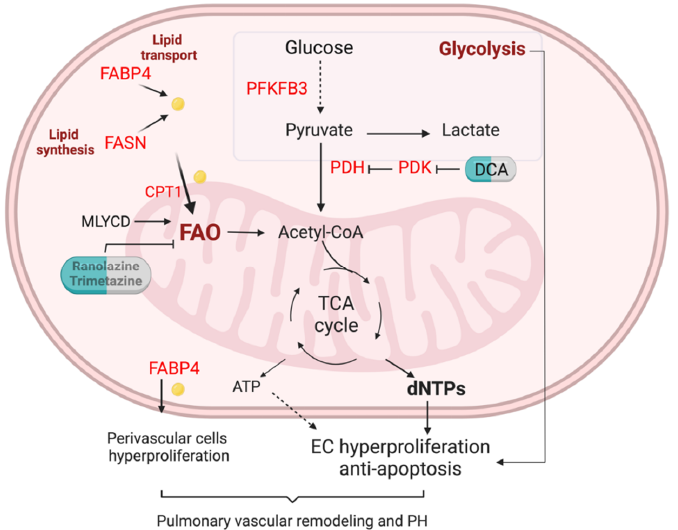
Figure 2. FA metabolism in the lung EC of pulmonary hypertension. Enhanced glycolysis is evident in PAH ECs. Lipid transport via FABP4, lipid synthesis via fatty acid synthase (FASN), and fatty acid oxidation (FAO) are unregulated in pulmonary arterials of PAH patients. Elevation of FA could increase mitochondria FAO, contributing to the generation of dNTPs and ATP. Enhanced FAO and glycolysis lead to PAH EC hyperproliferation and anti-apoptotic phenotypes. Upregulation of FAPB4 could also increase FA efflux to perivascular cells such as pulmonary arterial smooth muscle cells and fibroblasts, and promote pulmonary vascular remodeling and PH. Pulmonary arterial hypertension (PAH), or group 1 PH, is an incurable lung disease, characterized by increased resistance in the pulmonary vascular system, which will finally lead to elevated resting pulmonary artery pressure and end by right ventricular failure [82]. Accumulating evidence has demonstrated that EC dysfunction plays a crucial role in the initiation and progression of PAH, manifested by increased susceptibility to injury and enhanced proliferation, contributing to the formation of plexiform lesions [83–86]. Indeed, most PAH mutation-causing genes are mainly expressed in the lung ECs based on the human lung single-cell RNA sequencing analysis [87]. To date, increasing evidence indicates that EC metabolism dysfunction is closely associated with the pathogenesis of PAH [88–90]. The major observed metabolic alteration of EC metabolic change in PAH has increased glycolysis [88]. Glucose metabolic activities were higher in the lungs of PAH patients than in healthy individuals determined by in vivo fluorodeoxyglucose (FDG)-positron emission tomography (PET) scans [91,92]. Healthy ECs generate 85% of their energy from glycolysis. The glycolytic rate of PAH ECs is even greater compared to healthy ECs [91,92], suggesting that PAH ECs exhibit a further shift to aerobic glycolysis. Pulmonary vascular ECs sustain the proliferative and anti- apoptotic phenotypes depending on enhanced glycolysis. Mice with EC-specific deletion of PFKFB3, a key regulator of glycolysis, slowed PH development [93]. FA metabolism abnormality has been observed in PH. Metabolites profiling of the plasma from patients with PAH and healthy controls showed the dysregulated metabolic pathways. Metabolites representing lipid metabolism and fatty acid were closely associated with PAH [94]. Circulating levels of FABP4 were significantly elevated in PAH patients identified by plasma proteome profiling [94]. Lipid deposition is increased in the lungs of PH patients compared to control lungs [95]. FASN was upregulated in hypoxic pulmonary arterial smooth muscle cells (PASMCs) and pulmonary arterial ECs (PAECs), and monocrotaline (MCT)-treated rats (a widely used PH model) [79,96]. FASN inhibition using the C75 compound decreased right ventricular pressure, right heart hypertrophy,